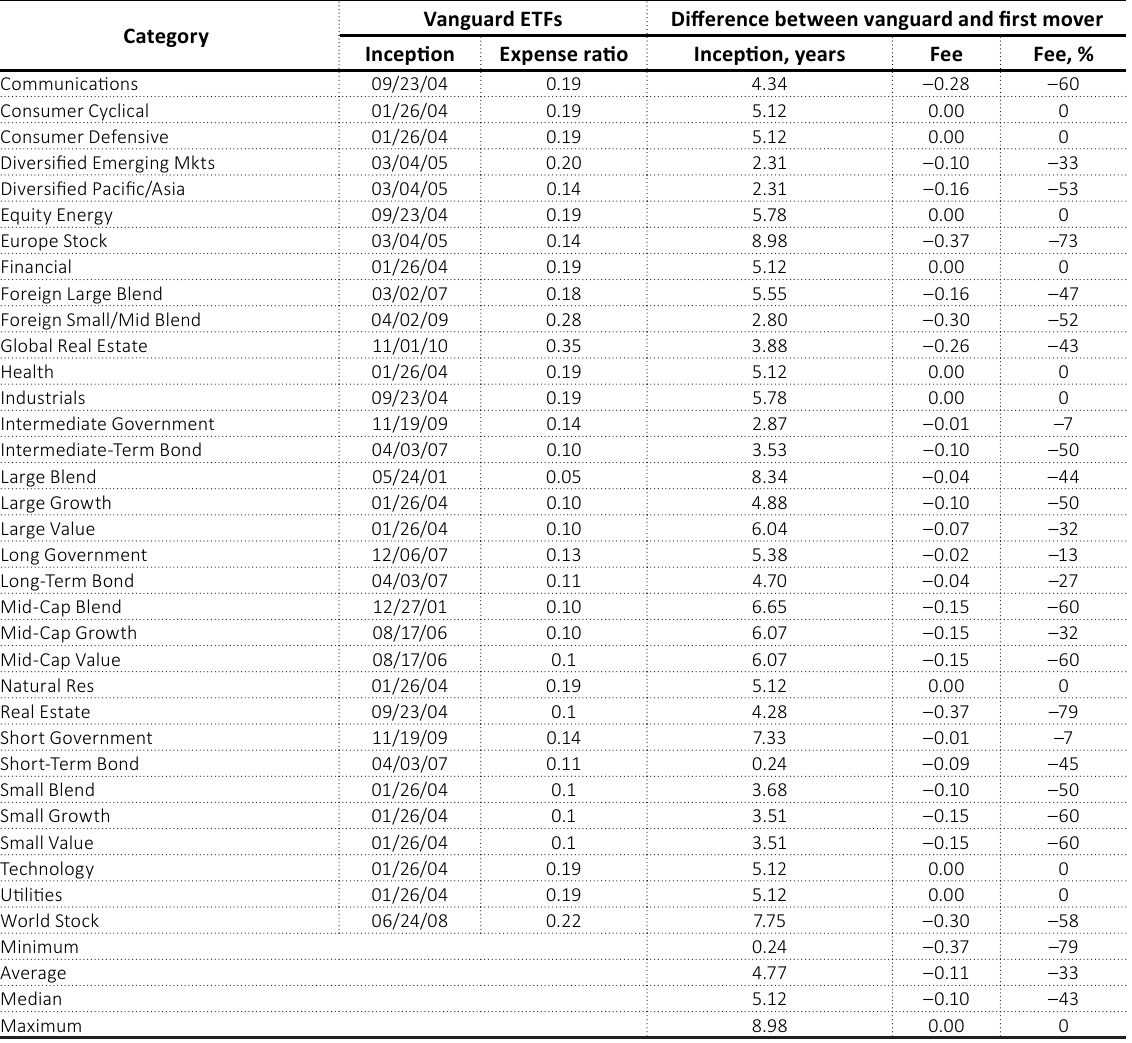
Table 3. Comparison of Vanguard ETFs with first